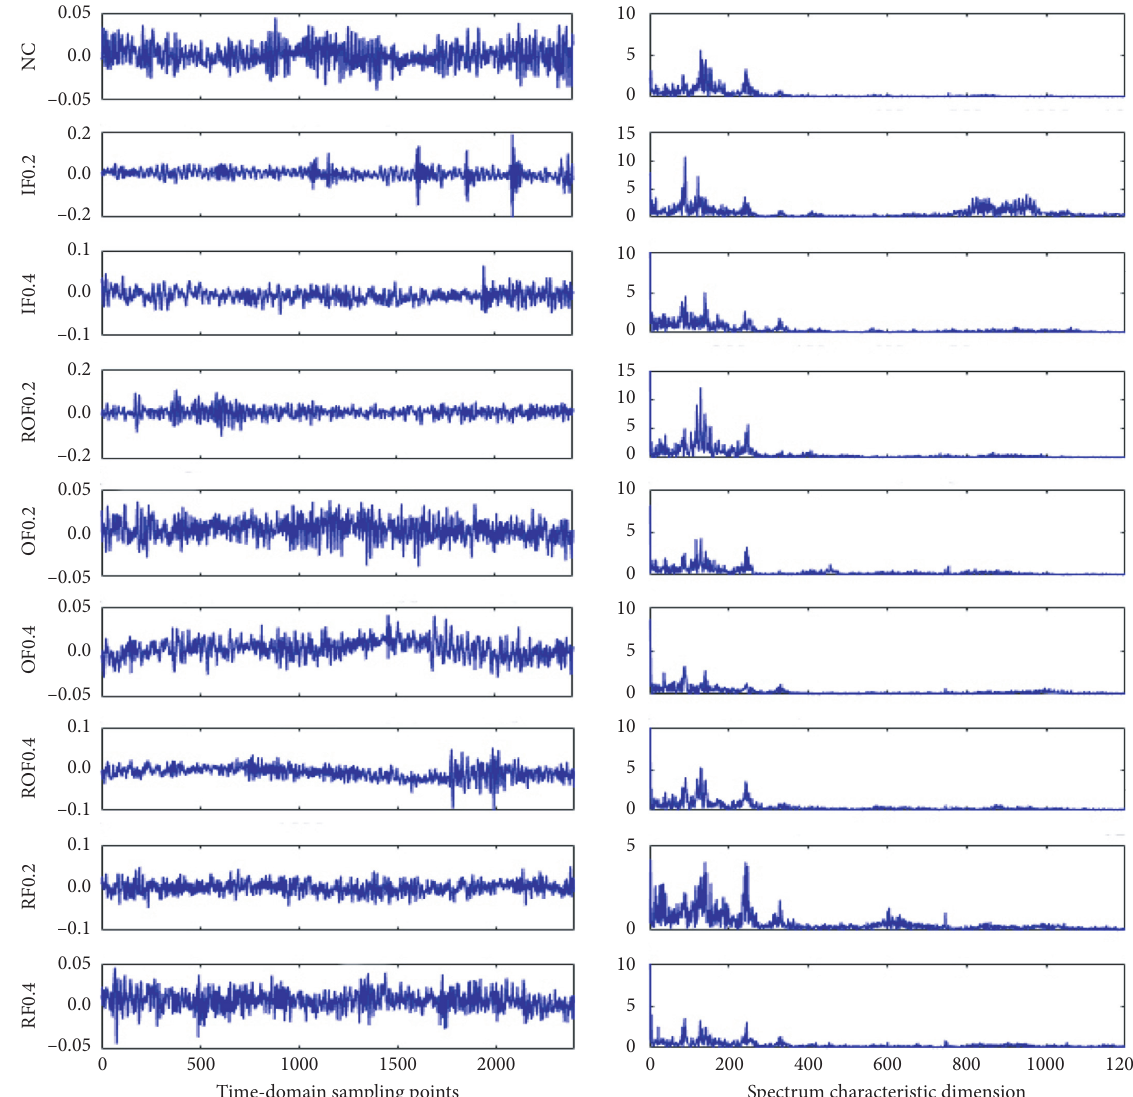
Figure 5: Time- and frequency-domain waveforms of bearing signals under the nine health